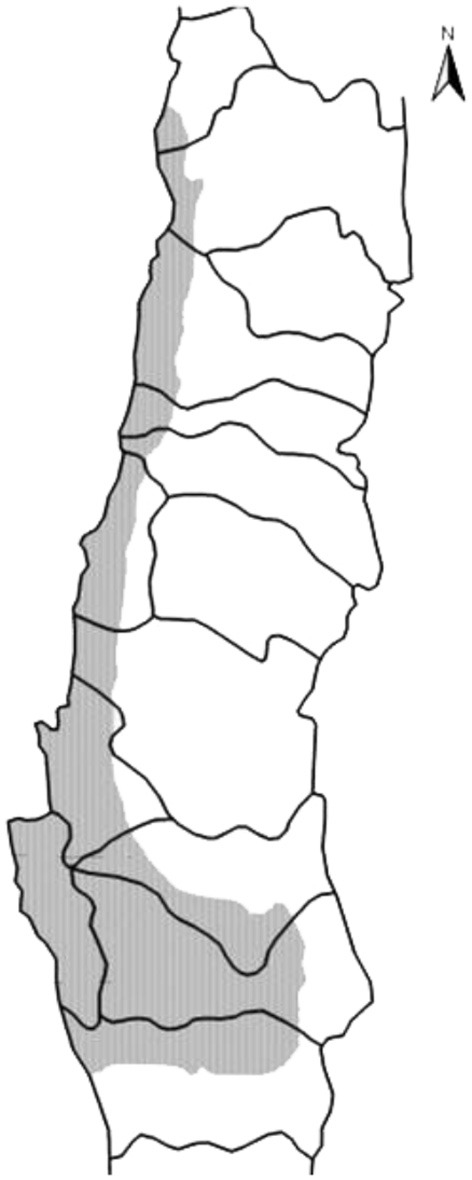
Eroded area (1943). Source: Bianchi (1947).